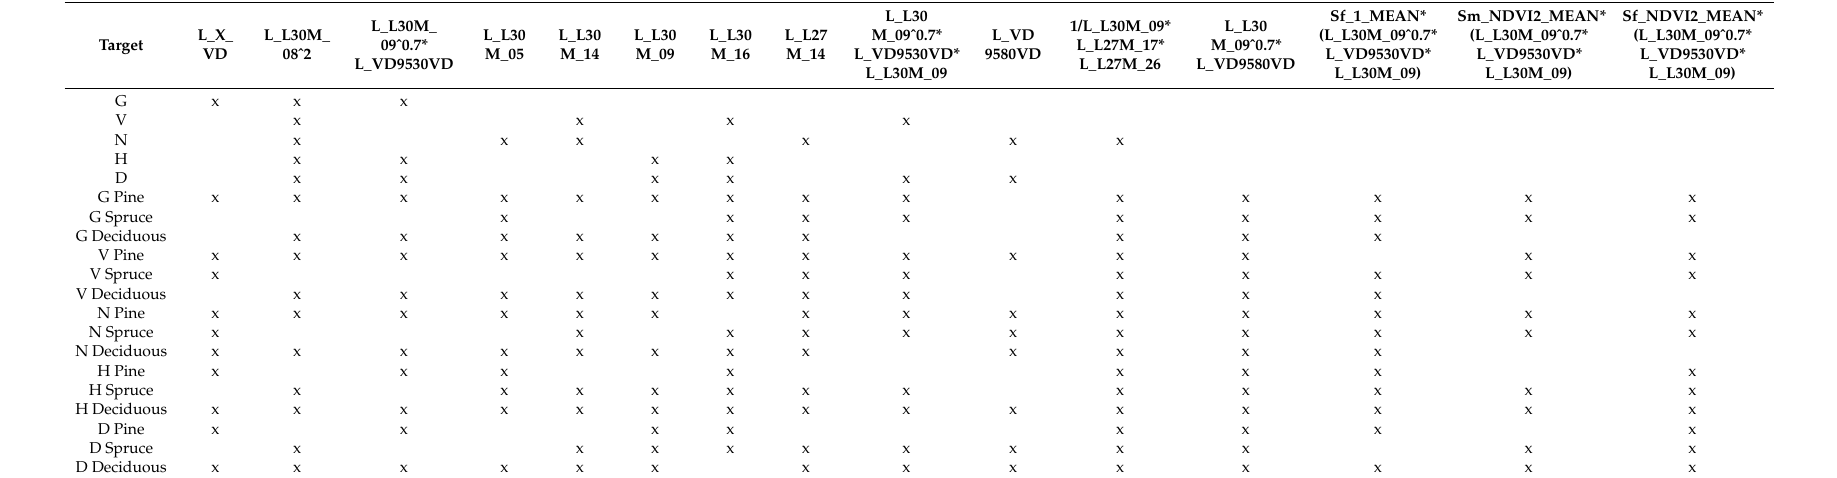
Table A2. List of variables used in the models. The names of the variables reflect the way they have been calculated from ALS data or from satellite images but describing those calculations is beyond the scope of the current